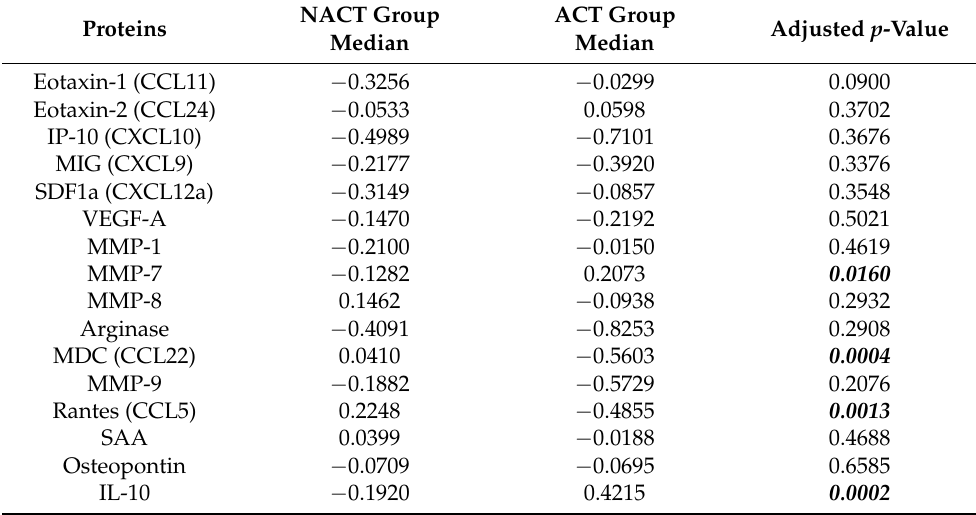
Table 2. Effect of the sequence in chemotherapy and debulking surgery on the immune environment.